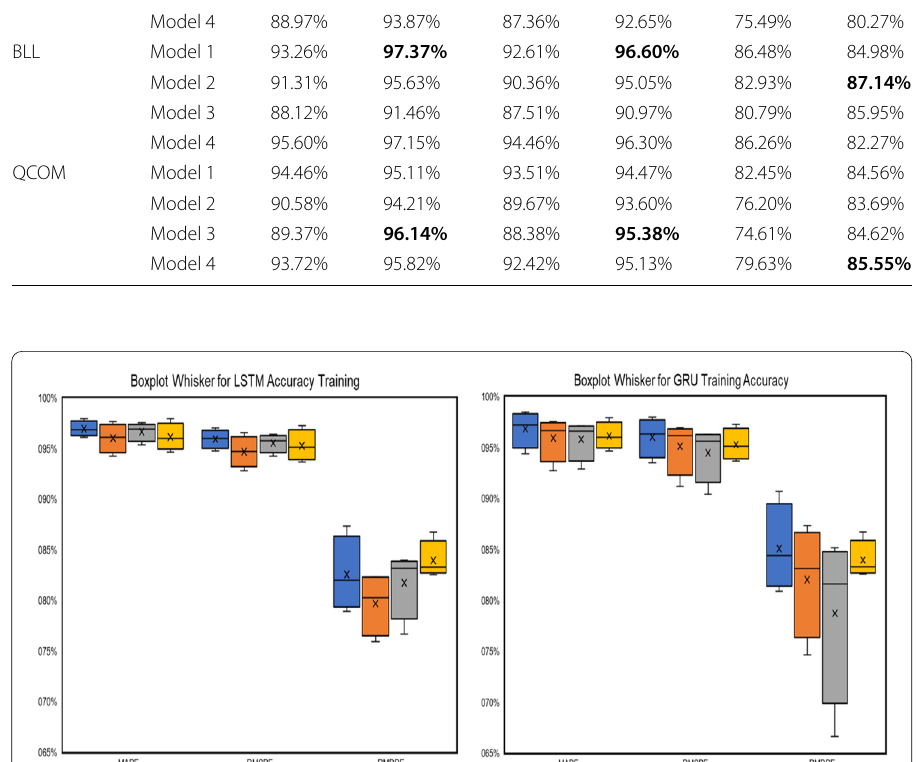
Fig. 15 Boxplot Whisker for LSTM and GRU trained